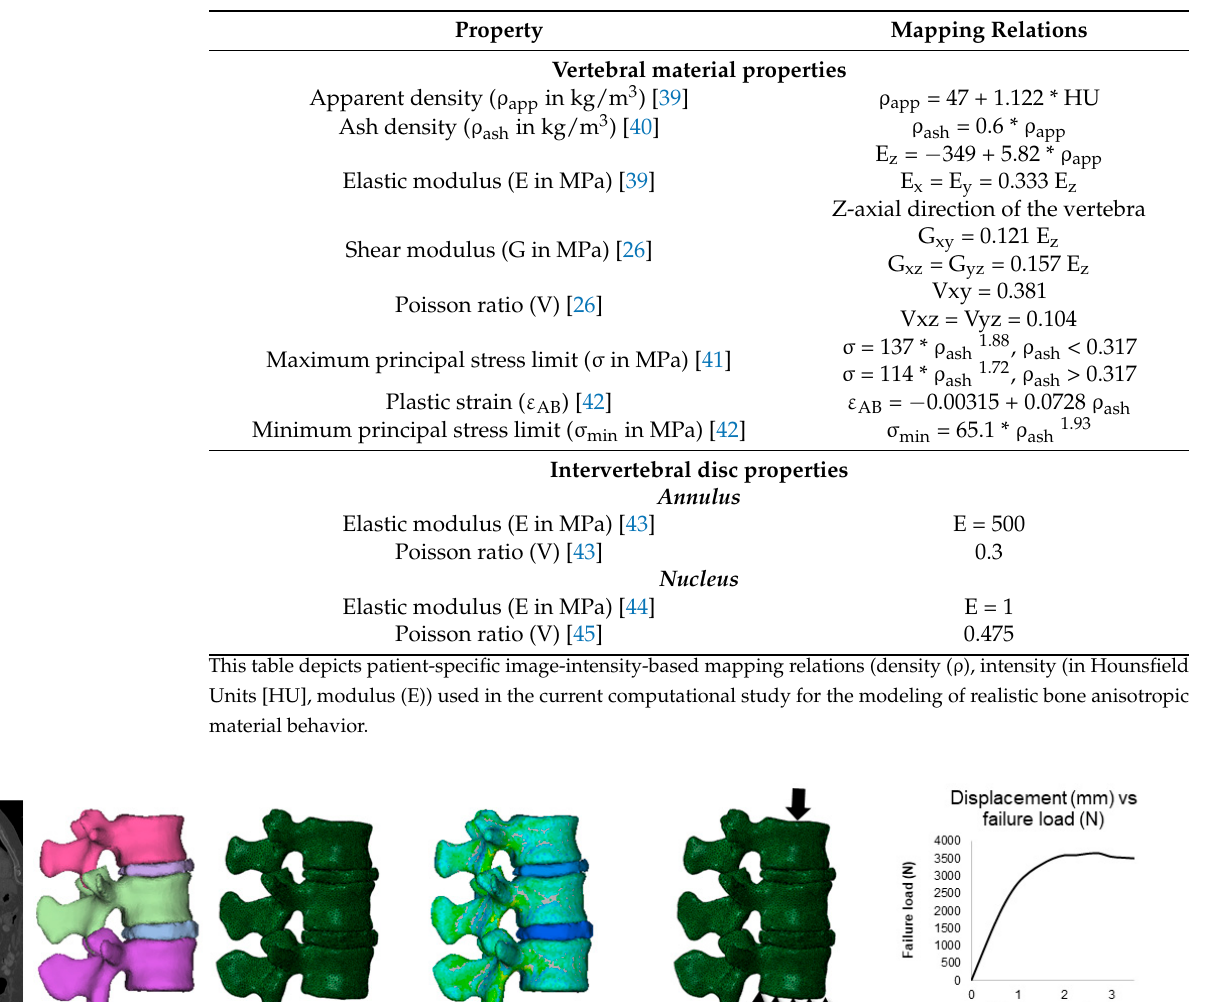
Table 1. Property and mapping relations.